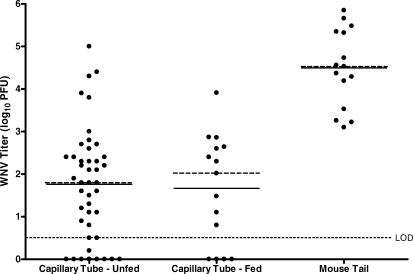
Mosquitoes Inoculate Higher WNV Doses into Mouse Tails than into Glass Capillary TubesIntrathoracically inoculated Cx. tarsalis females (n = 15) probed/fed on a mouse tail; the tail was removed and macerated, and WNV titer was determined (Mouse Tail). Salivary secretions were collected 2–4 h later from these same mosquitoes by an in vitro capillary tube transmission assay (Capillary Tube – Fed). At the same time, salivary secretions were collected from intrathoracically inoculated female Cx. tarsalis from the same cohort that had not fed on a mouse tail (n = 44) (Capillary Tube – Unfed). Shown are the combined data from two independent studies. Mean and median WNV titers in each column are designated by solid and dashed horizontal lines. LOD of plaque assay is shown.